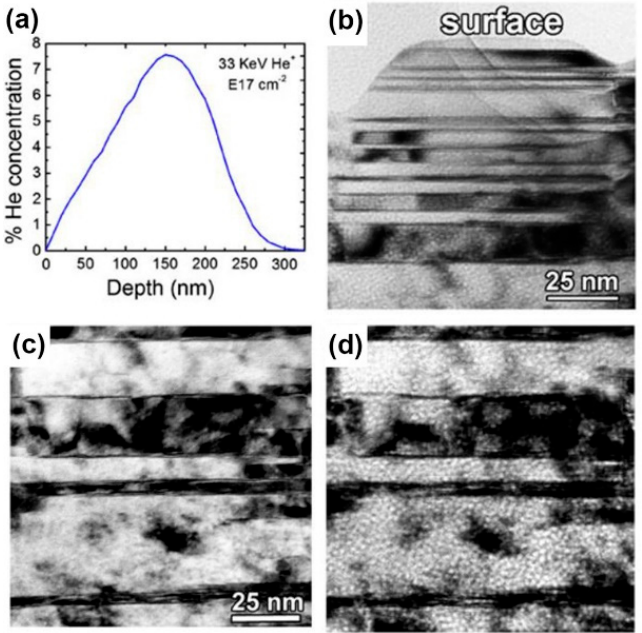
Figure 15. ( a ) Depth profile of He concentration in nanotwined (NT) Cu film implanted to a dose of 1 × 10 17 ions/cm 2 with 33 keV He ions, calculated using the stopping and range of ions in matter (SRIM). ( b ) Under-focused ( − 2 um) bright field TEM image from near surface. ( c , d ) Near-focus and under-focused ( − 2 um) bright field TEM images from a depth of 150 nm (peak He concentration) [50].